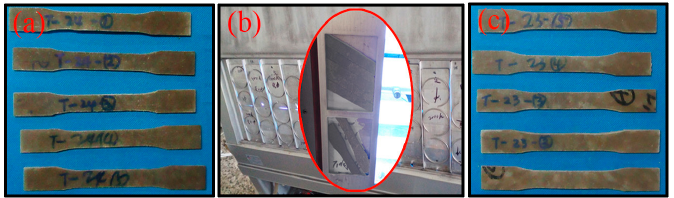
Table 1. Formulations of various samples for the preparation of the foamed wheat straw fiber/PP